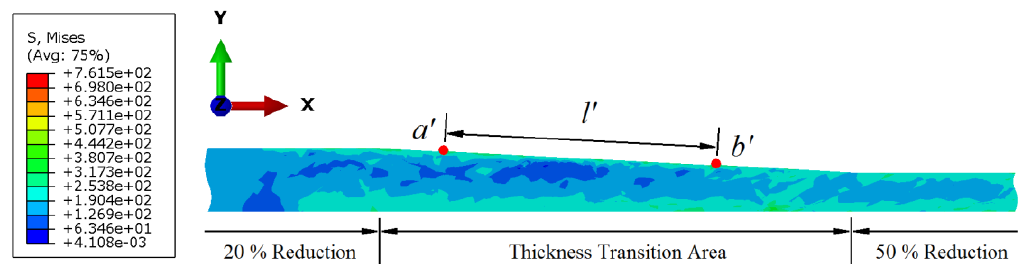
Figure 4. Profile of the micro flexible rolled sample with a reduction of 20% to 50%.